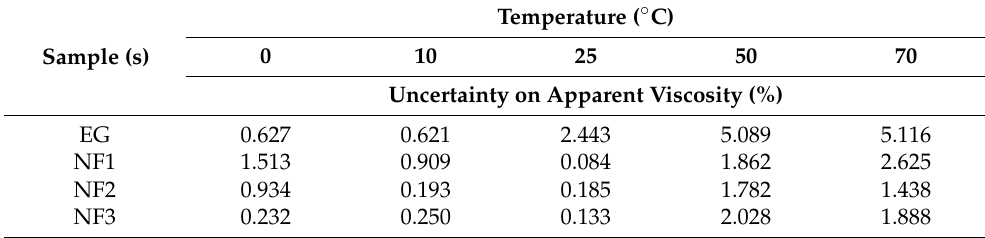
Table 1. Uncertainty data on the dynamic viscosity.